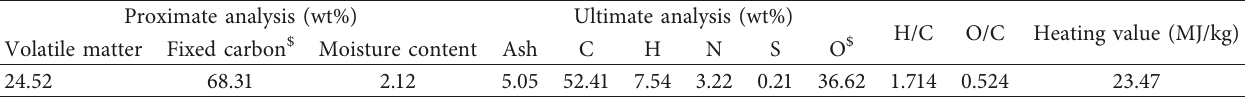
Table 4: Component analysis of